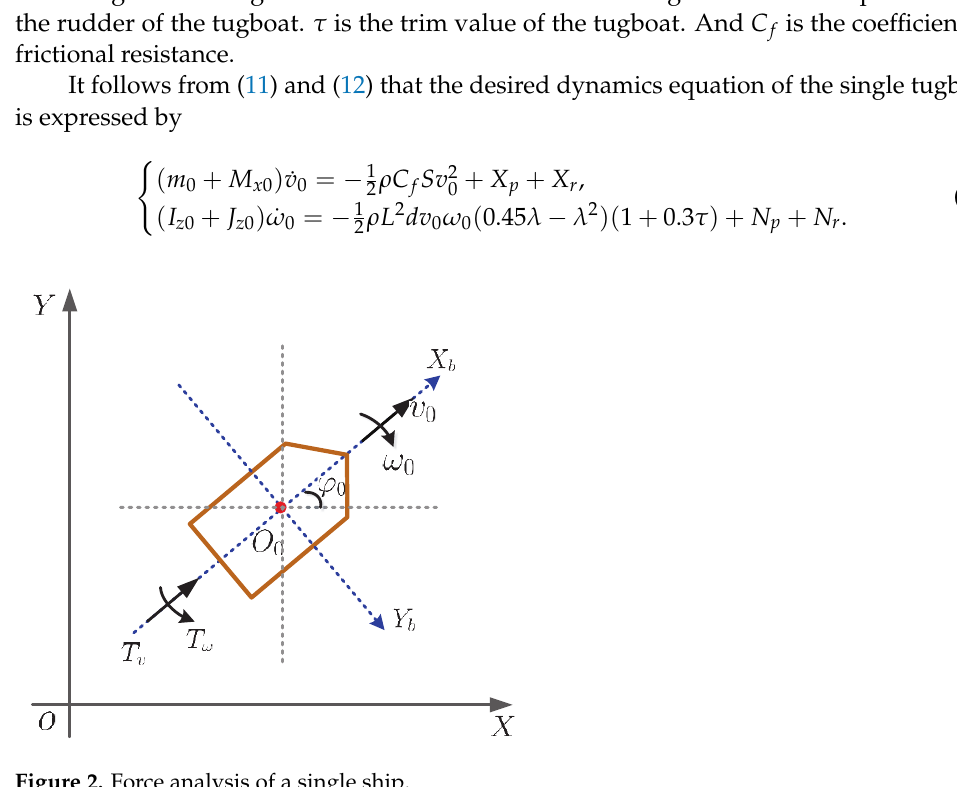
Figure 2. Force analysis of a single